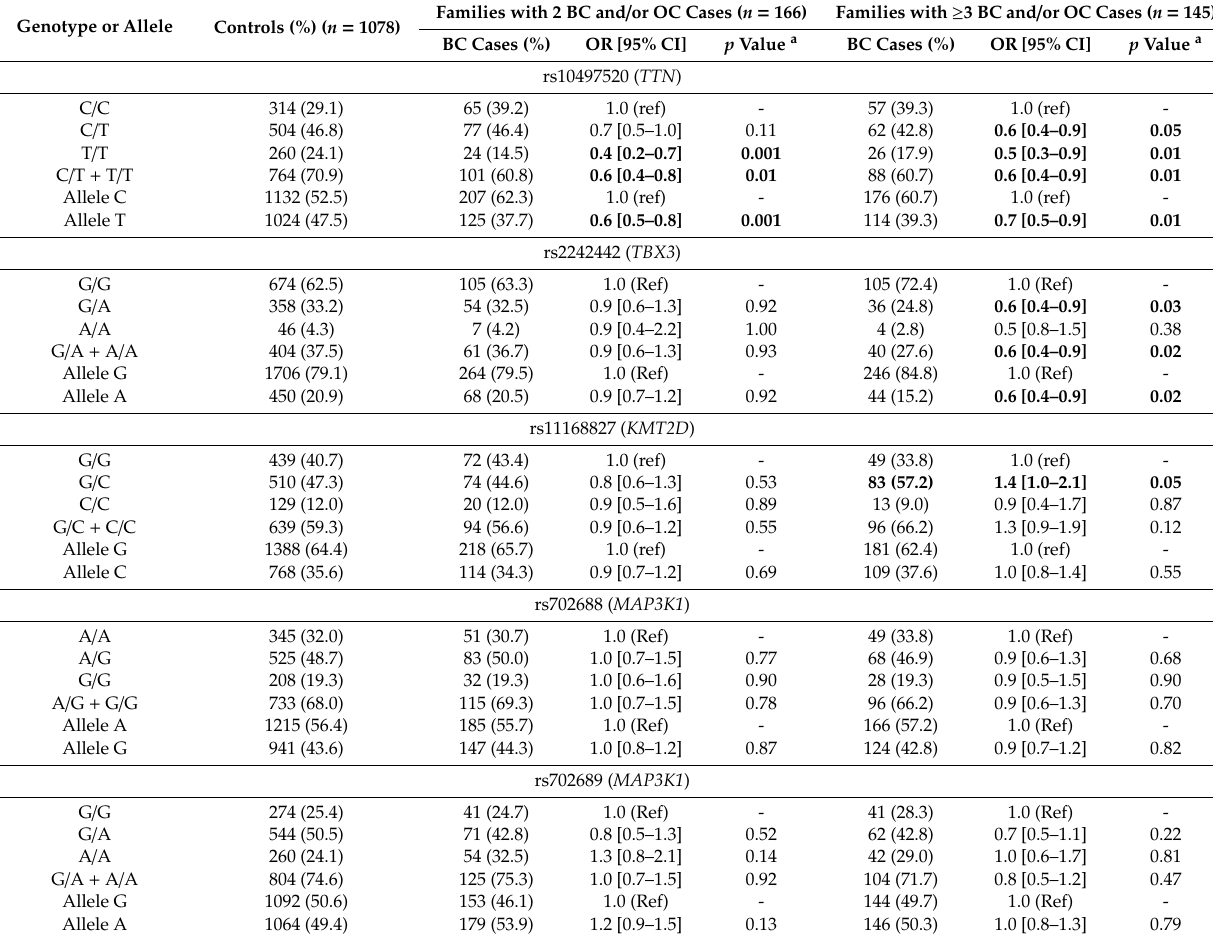
Table 2. Genotype and allelic frequencies of rs10497520 ( TTN ), rs2242442 ( TBX3 ), rs11168827 ( KMT2D ), rs702688 and rs702689 ( MAP3K1 ) according the number of BC cases in the families in BRCA1 / 2 -negative breast cancer cases and